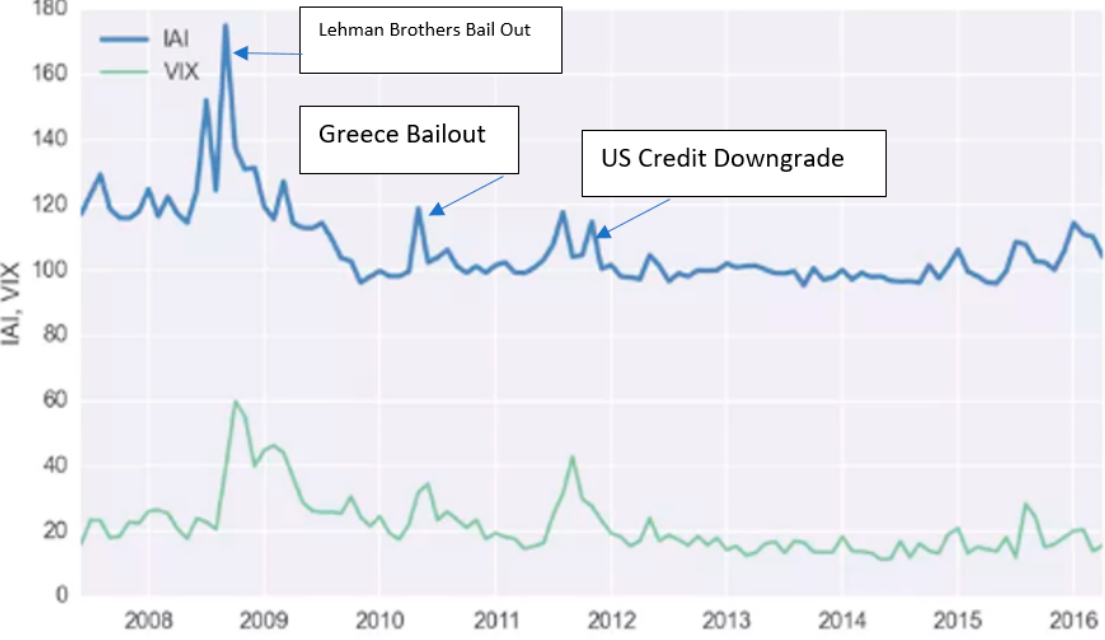
Figure 2. The Investopedia Anxiety Index ( IAI ) and VIX. Source: https://www.investopedia.com/anxiety-index-explained/